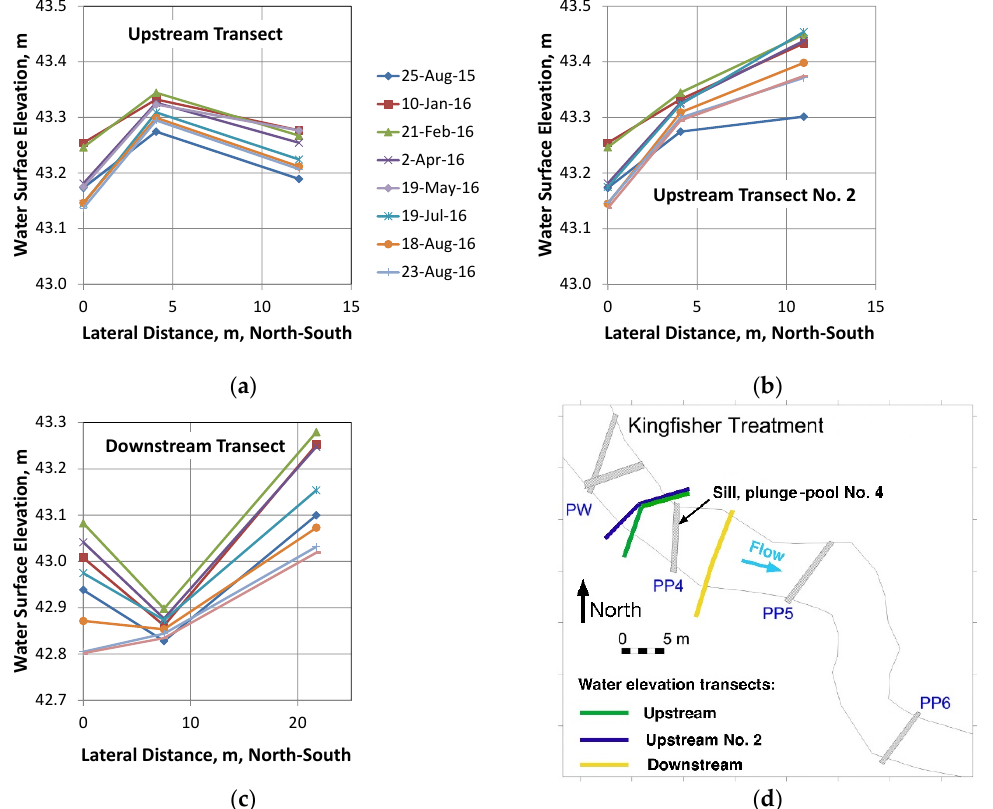
Figure 14. Water surface elevations along lateral transects, oriented as viewed from upstream. First upstream transect is shown in ( a ), second upstream transect in ( b ) and downstream transect in ( c ). Transect locations shown in ( d ).